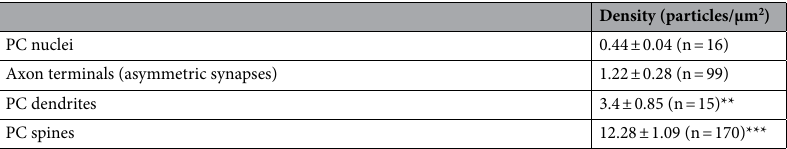
phological resemblance may be misleading.